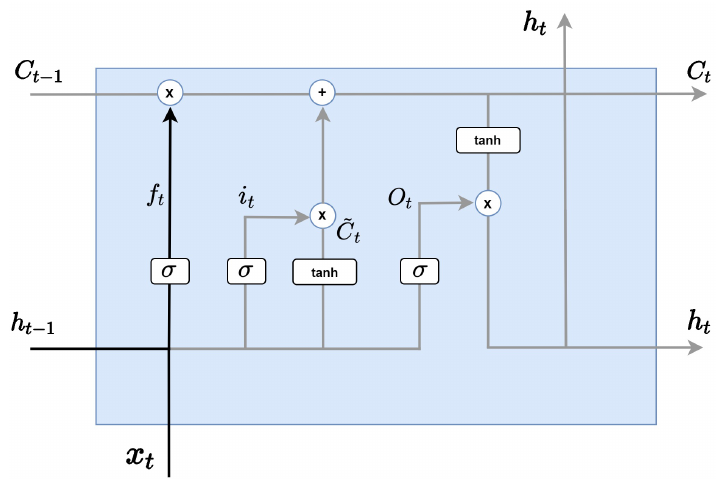
Figure 3. LSTM forget gate layer.